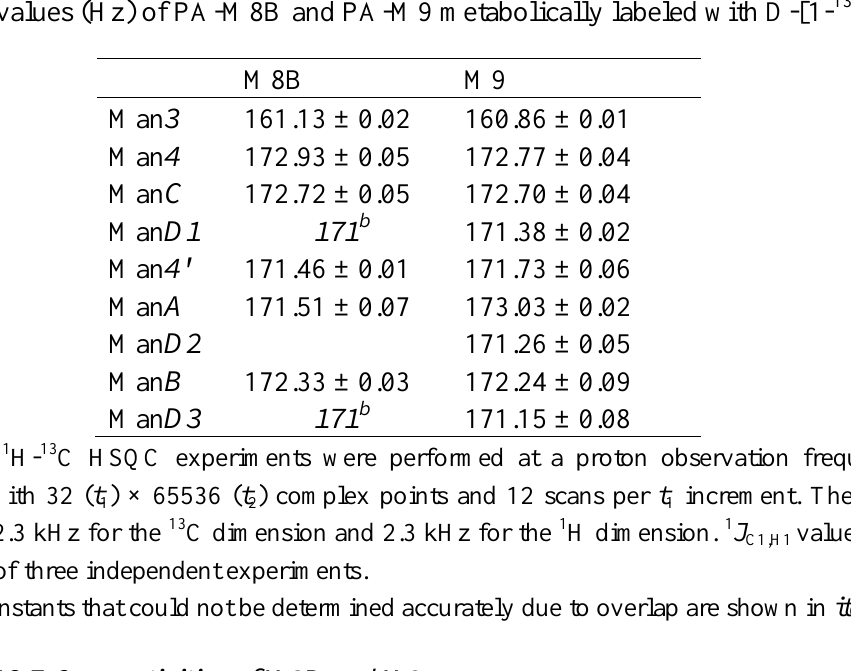
Table 1. 1 J values (Hz) of PA-M8B and PA-M9 metabolically labeled with D-[1- 13 C]glucose. C1,H1